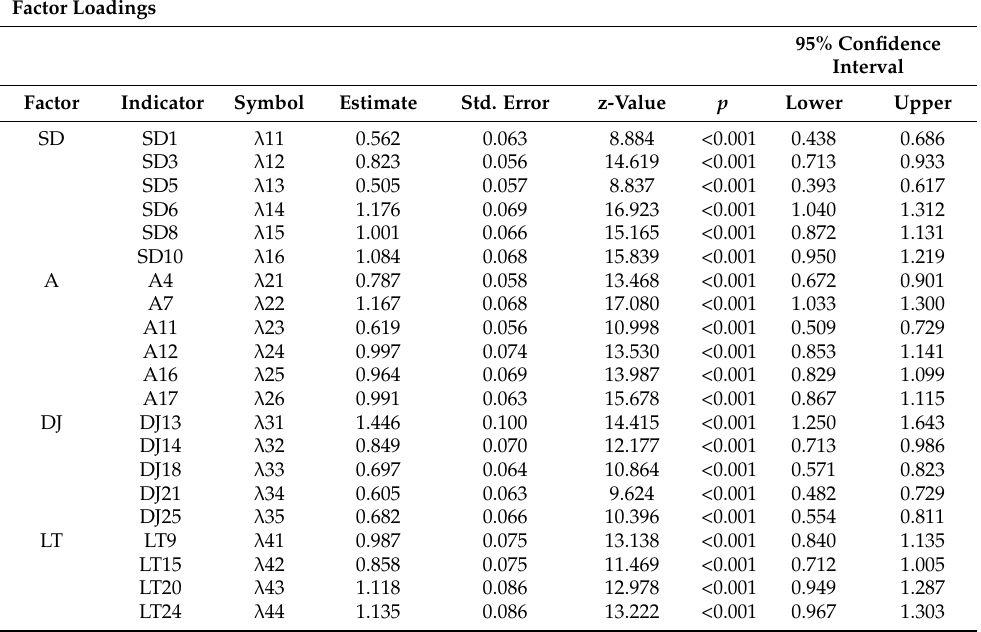
Table 5. CFA measurement model for men: Factors, estimates of factor loadings, standards errors, and statistical